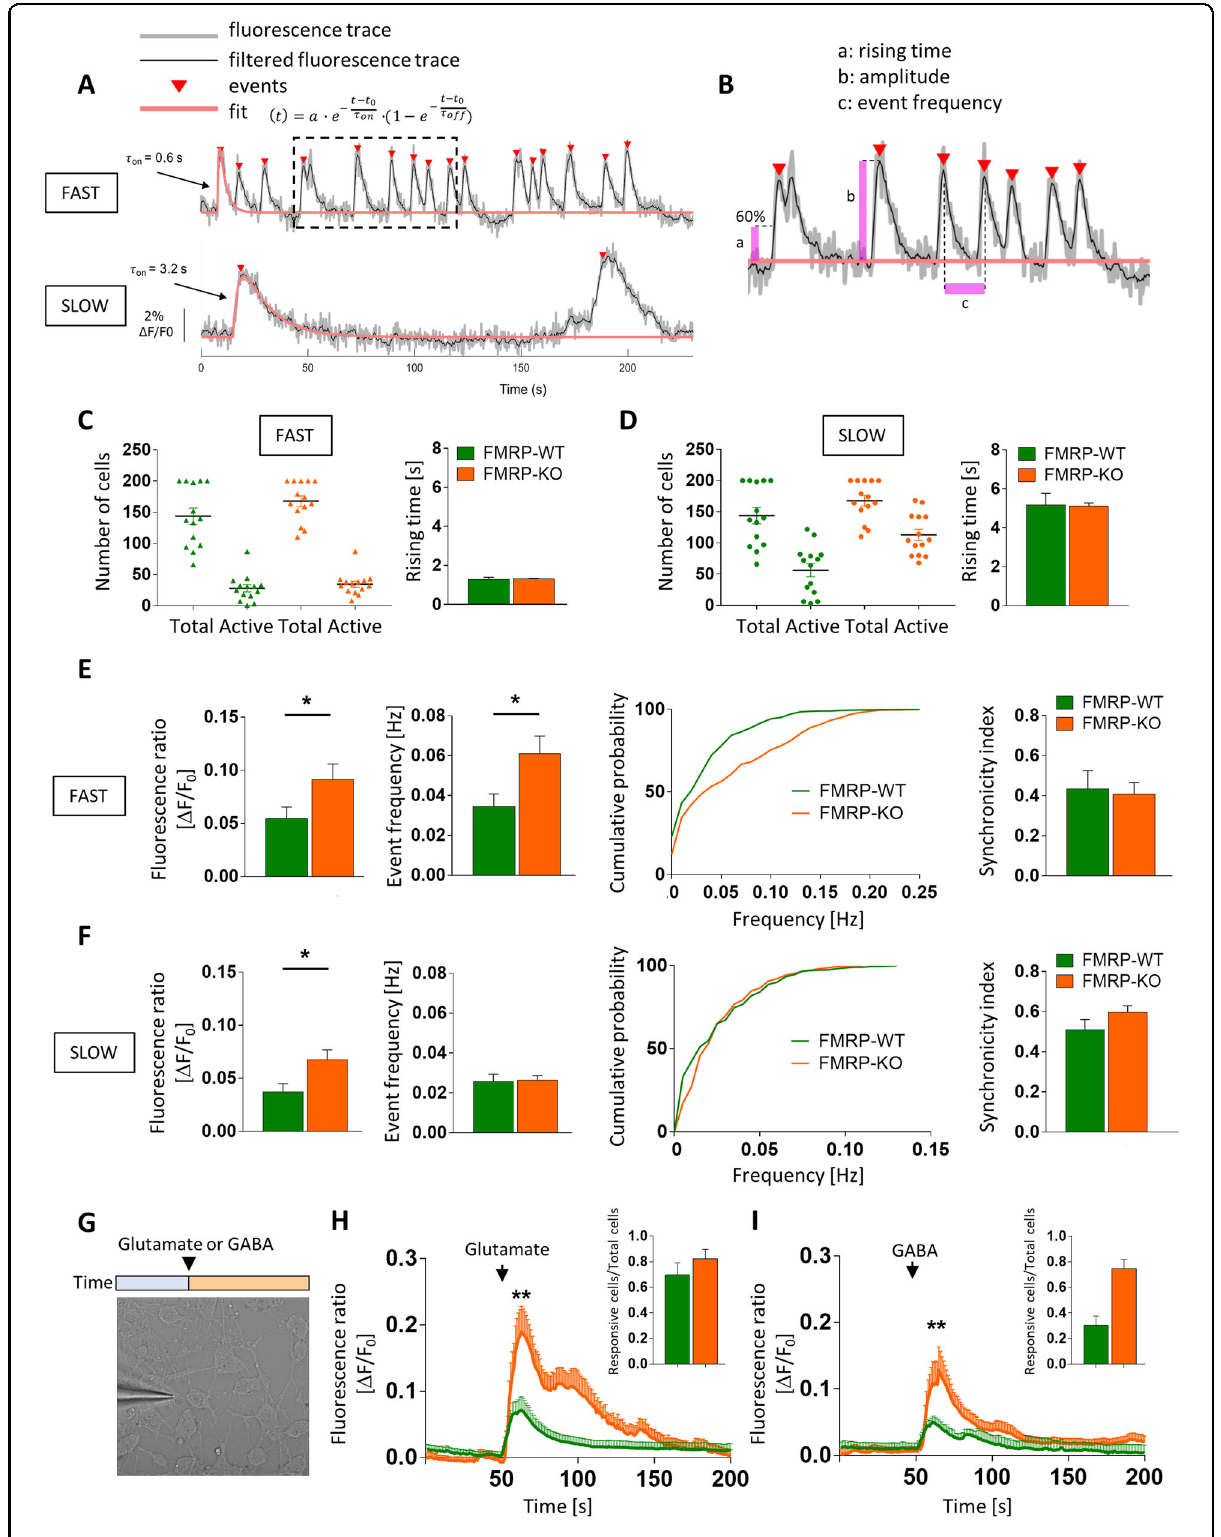
Fig. 5 (See legend on next